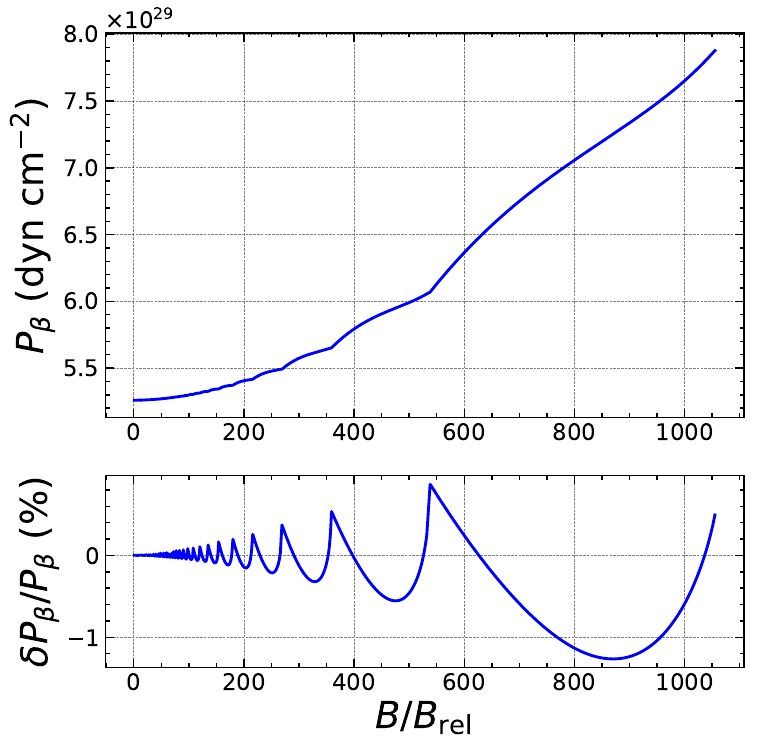
Figure 11. Top panel : Exact threshold pressure (in cgs units) for the onset of electron captures by 122 Zr as a function of the magnetic field strength B (cid:63) = B / B rel up to the onset of the strongly quantizing regime. Bottom panel : Relative error (in %) of the approximate analytical